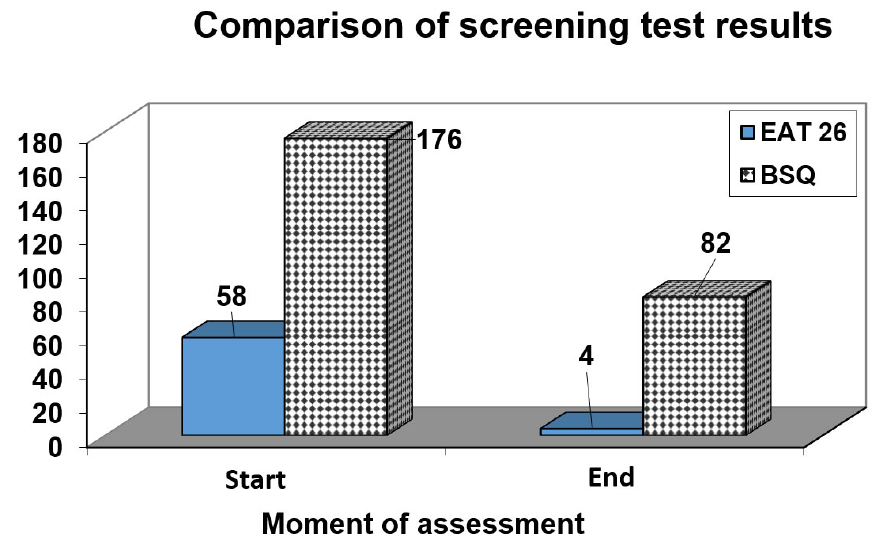
Figure 2. Comparison of EAT ‐ 26 and BSQ results between the beginning and end of therapy.